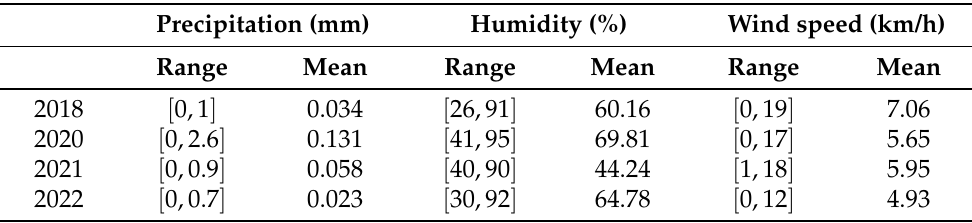
Table 3. Descriptive statistics for precipitation, humidity, and wind speed in Skopje in May